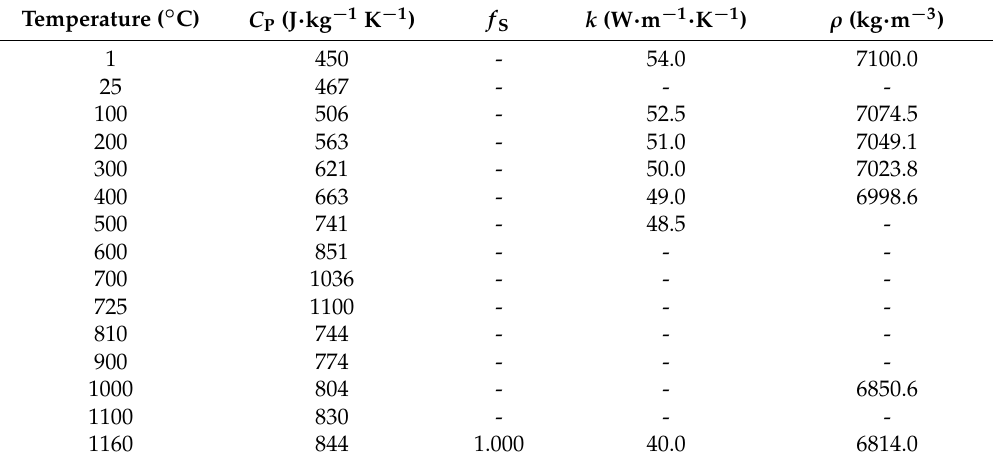
Table A1. Material properties for the alloy in the numerical